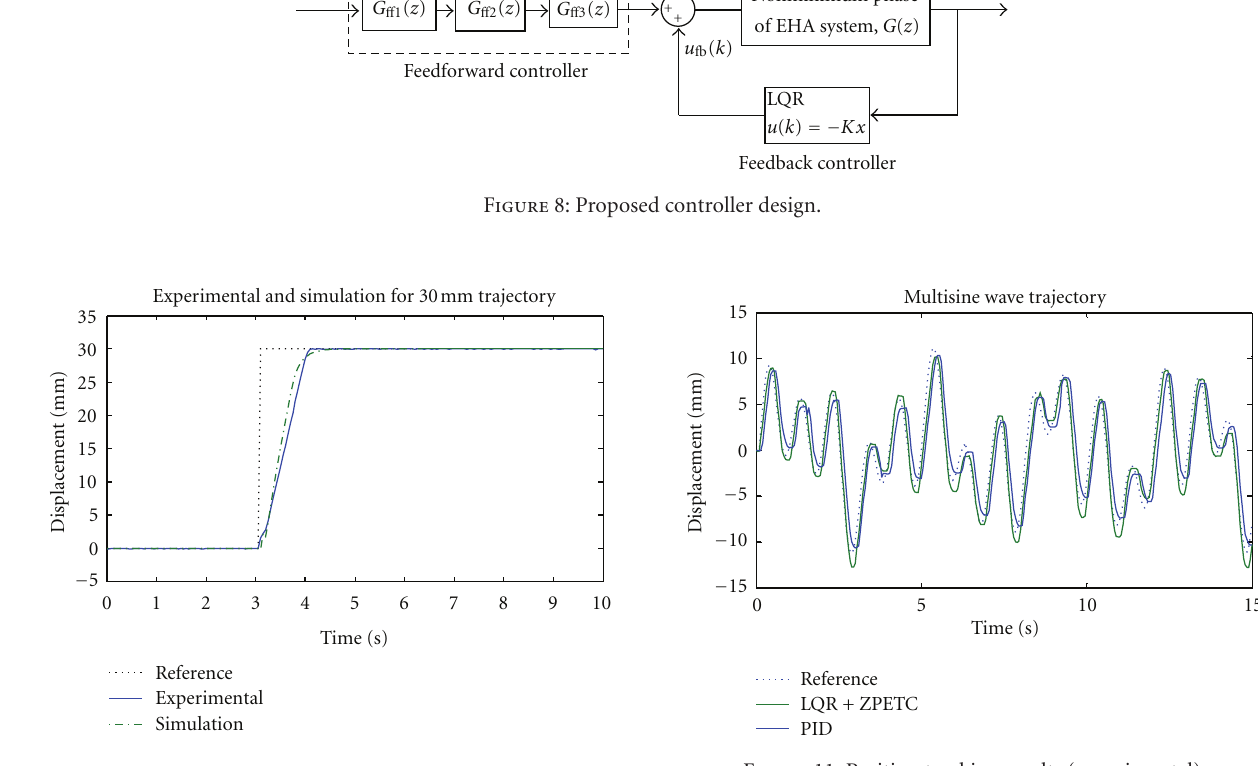
Figure 11: Position tracking results (experimental).